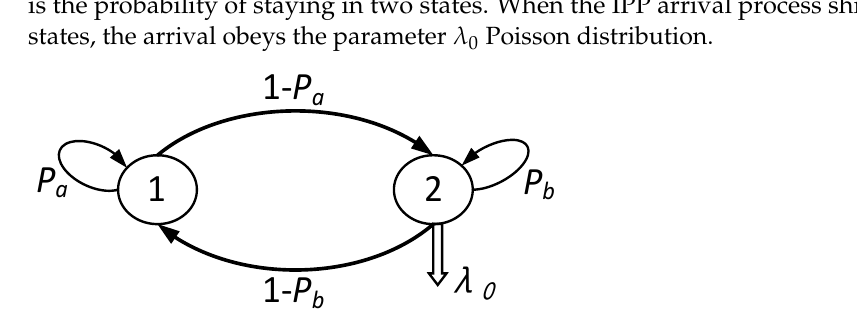
Figure 2. State transition diagram of an interrupted Poisson process.